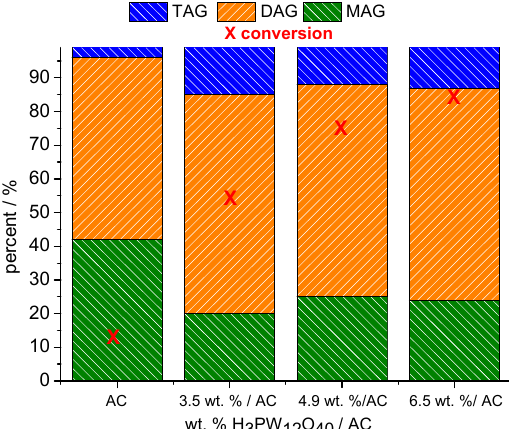
Figure 5. Conversion and selectivity to the products of the esterification of glycerol with acetic acid over H 3 PW 12 O 40 /AC catalyst (adapted from ref. [48]). Reaction conditions: molar ratio of glycerol to acetic acid (1:16); temperature (393 K); catalyst loading (0.2 g).